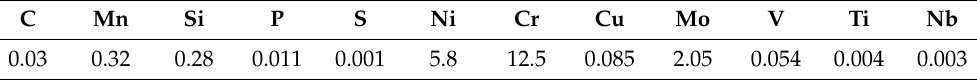
Table 1. Chemical composition of the supermartensitic stainless steel